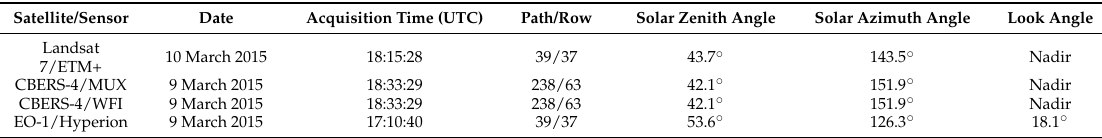
Table 4. Metadata of scenes used for MUX, WFI/ETM+ cross